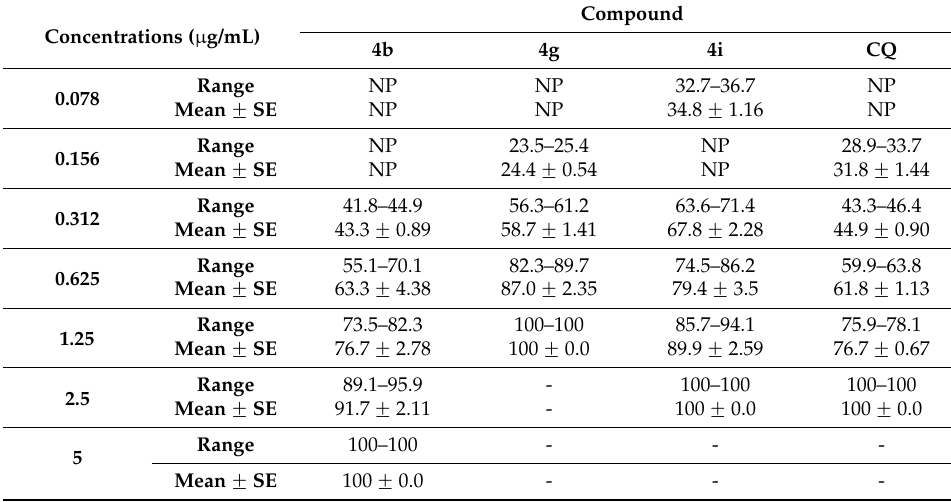
Table 2. % Parasite inhibition of Plasmodium falciparum (% Mean Parasite Inhibition per 1500 RBC) of compounds 4b , g , i .